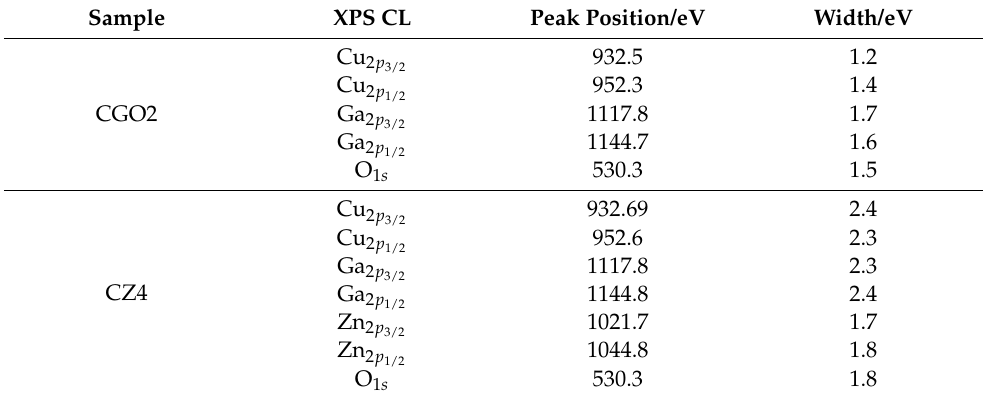
Table 2. Peak position and width ( ± 0.1 eV) of each of the XPS CL peaks for CGO2 and CZ4.